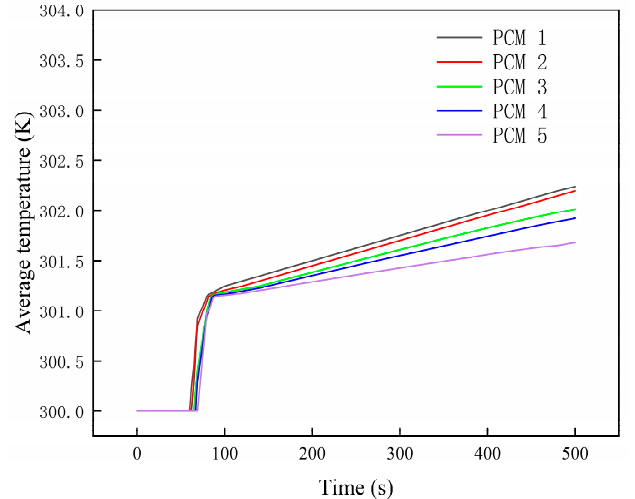
Figure 15. The average temperature change in the PCM in different regions when the No. 1 battery is thermally runaway.